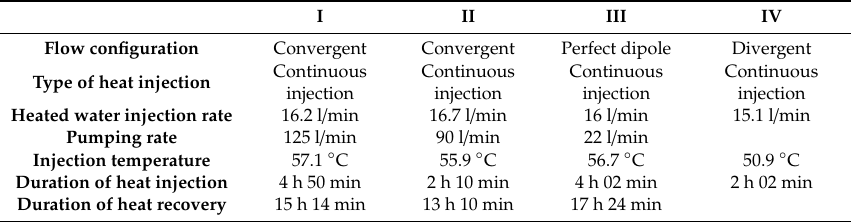
Figure 3. Conceptual scheme and streamlines during single-well flow tests in ( a ) perfect dipole configuration and ( b ) convergent dipole configuration. Table 1. Experimental set up of the three heat tracer tests and the heat injection